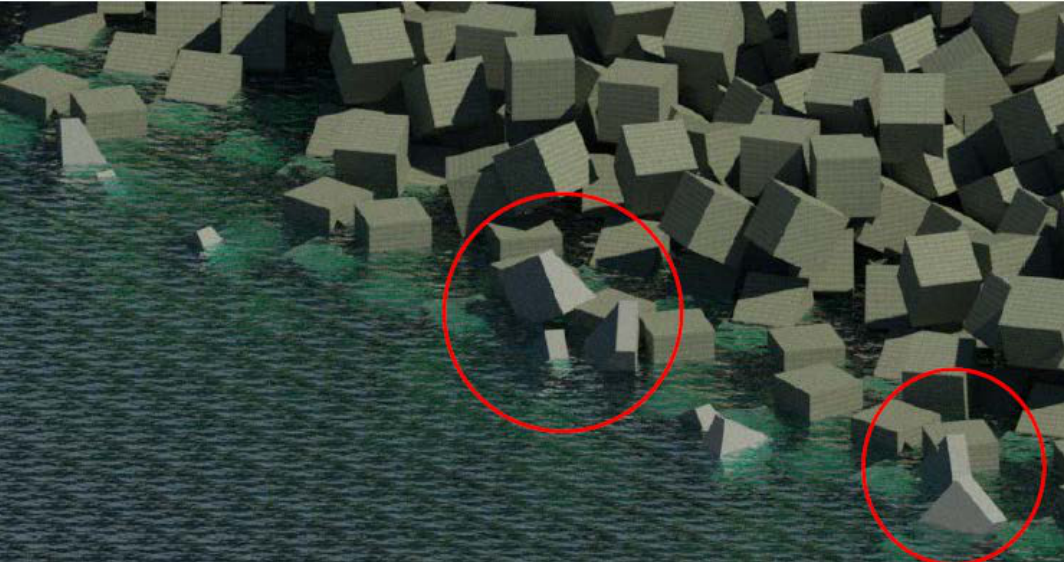
Figure 8. Breaking of 150 t concrete blocks of the armor of the main breakwater.